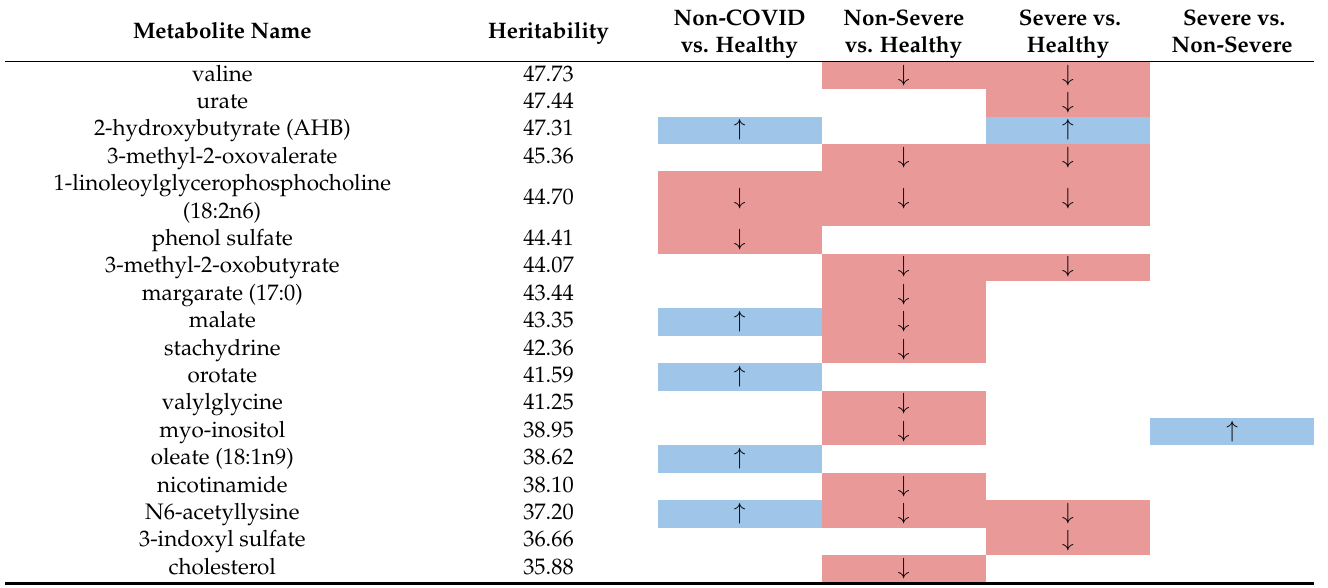
Table 2. Heritable proteins differentially expressed in COVID-19 disease states. Proteins with ≥ 30% heritability in erythrocytes were identified. ↑ /blue indicates upregulation in the associated disease state (non-COVID-19, non-severe COVID-19, and severe COVID-19) in the [9] dataset; ↓ /red indicates downregulation. Proteins represented in the “Upregulated in COVID” column were identified in the [8] dataset; no downregulated proteins in this study met the heritability threshold.